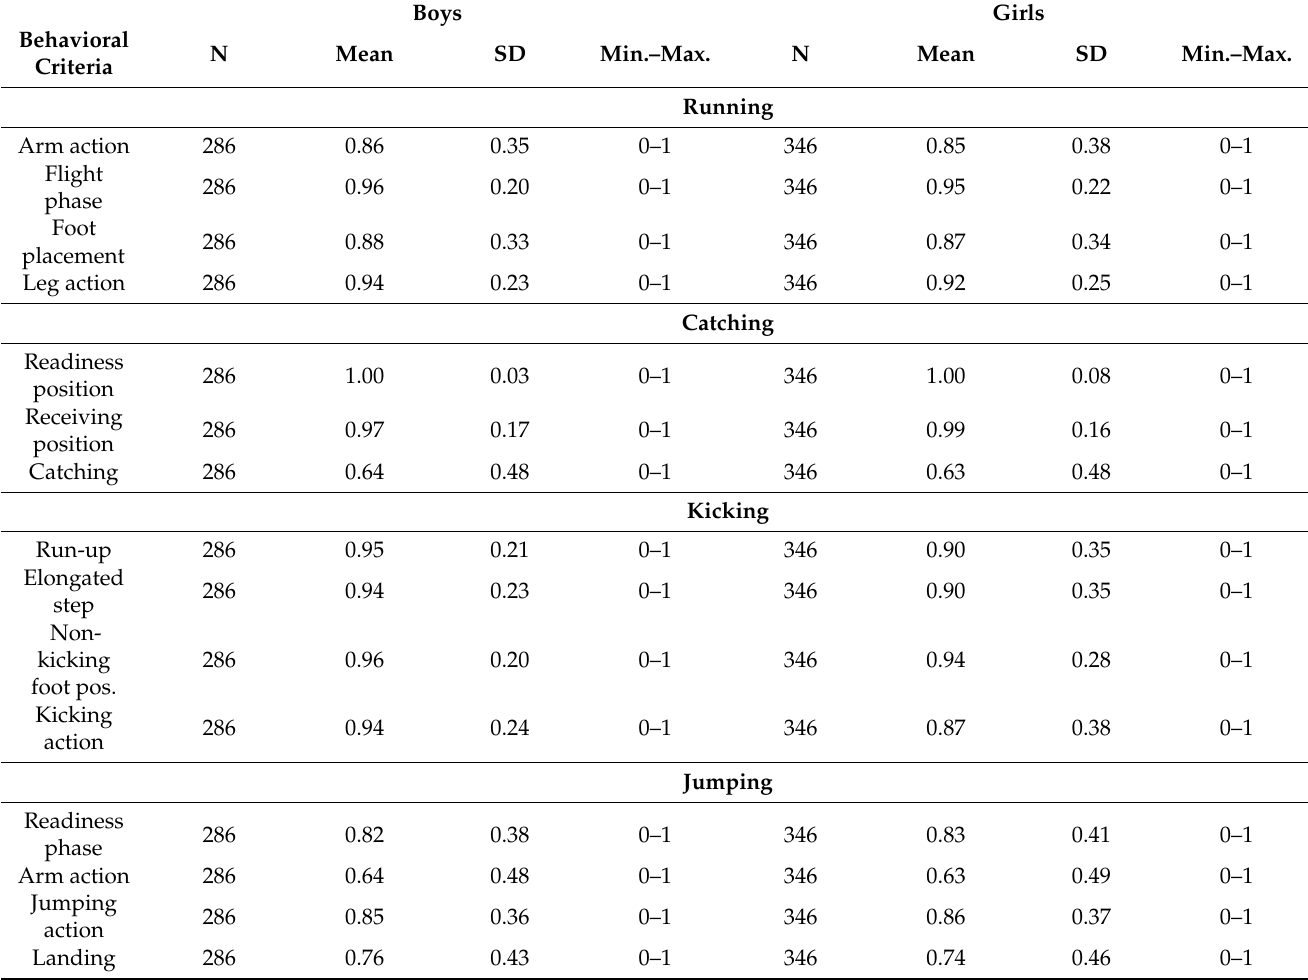
Table 3. Descriptive performance criteria of the running, catching, kicking, and jumping skills of boys and